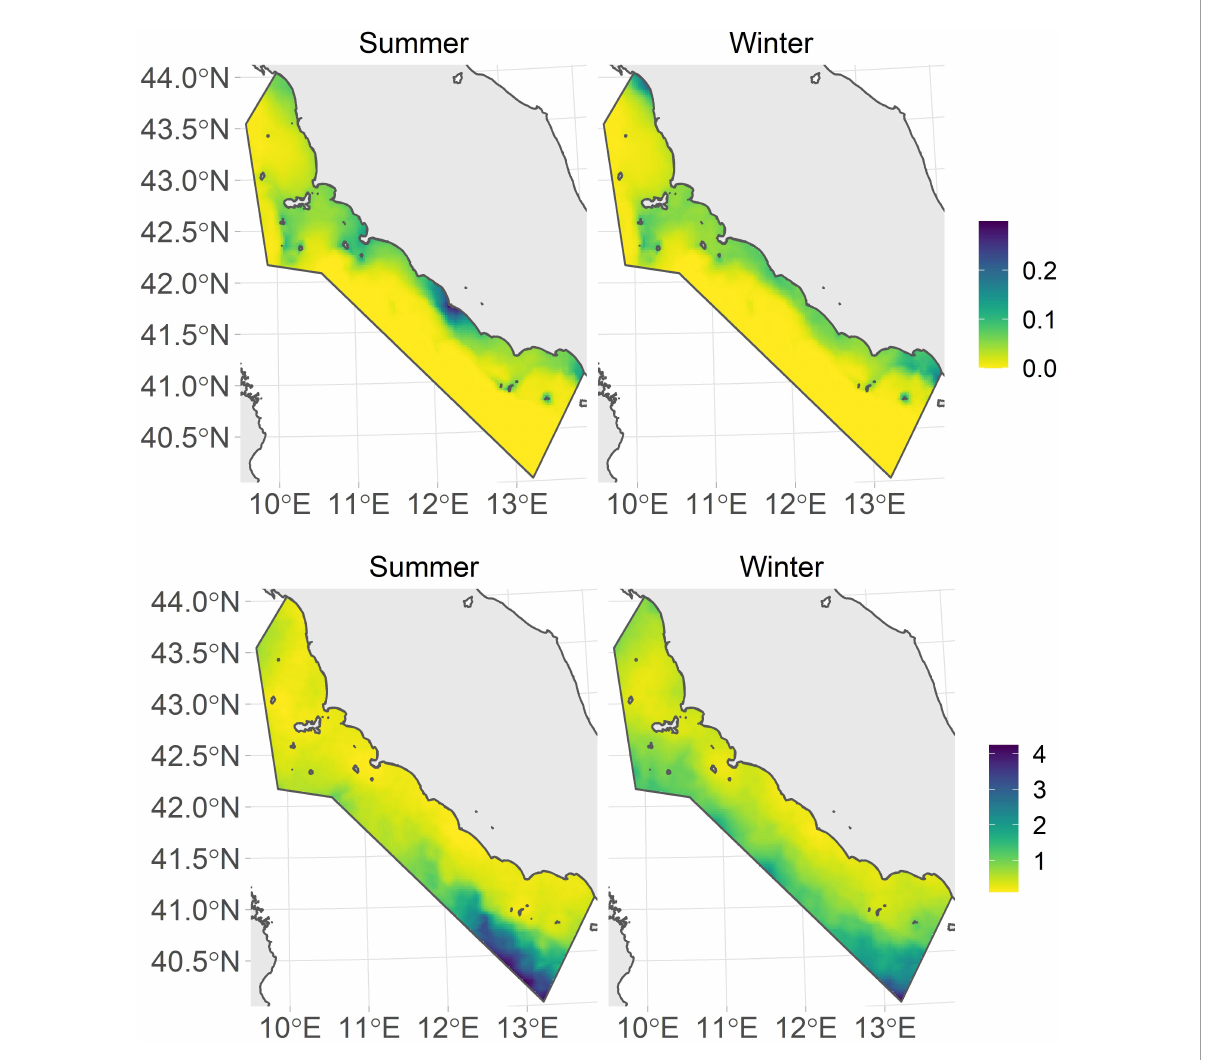
FIGURE 6 Posterior means of the predicted intensity surface for bottlenose dolphin distribution during the summer (upper left panel) and winter (upper right panel) seasons and the coef fi cient of variation (CV) for each season (summer: lower left panel; winter: lower right panel).